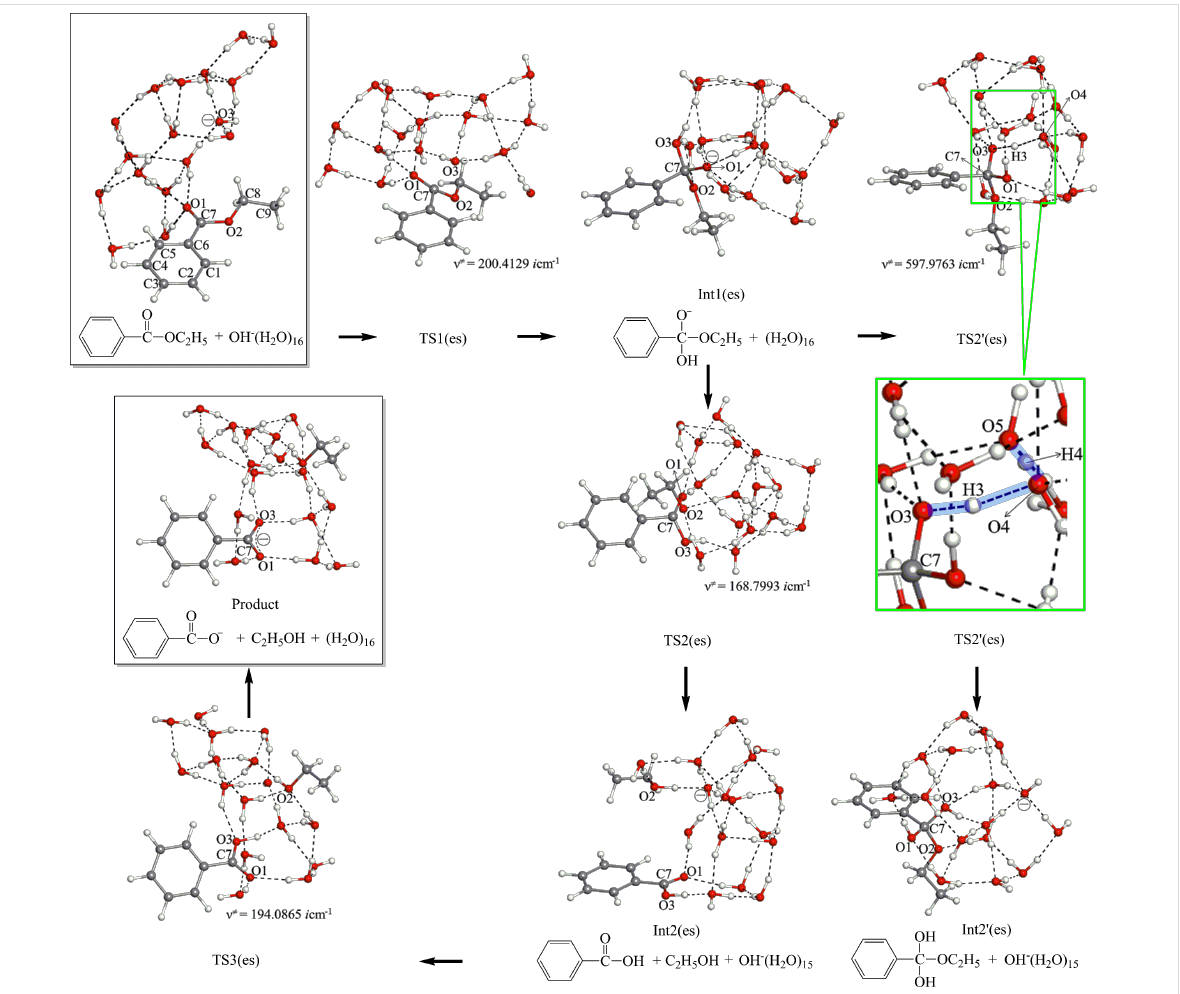
Figure 4: Reaction paths of the ester n = 16 hydrolysis, starting from the boxed reactant-like complex toward the boxed product. To TS2'(es), the magnified cut figure is attached. XYZ coordinates in VII.c (Supporting Information File